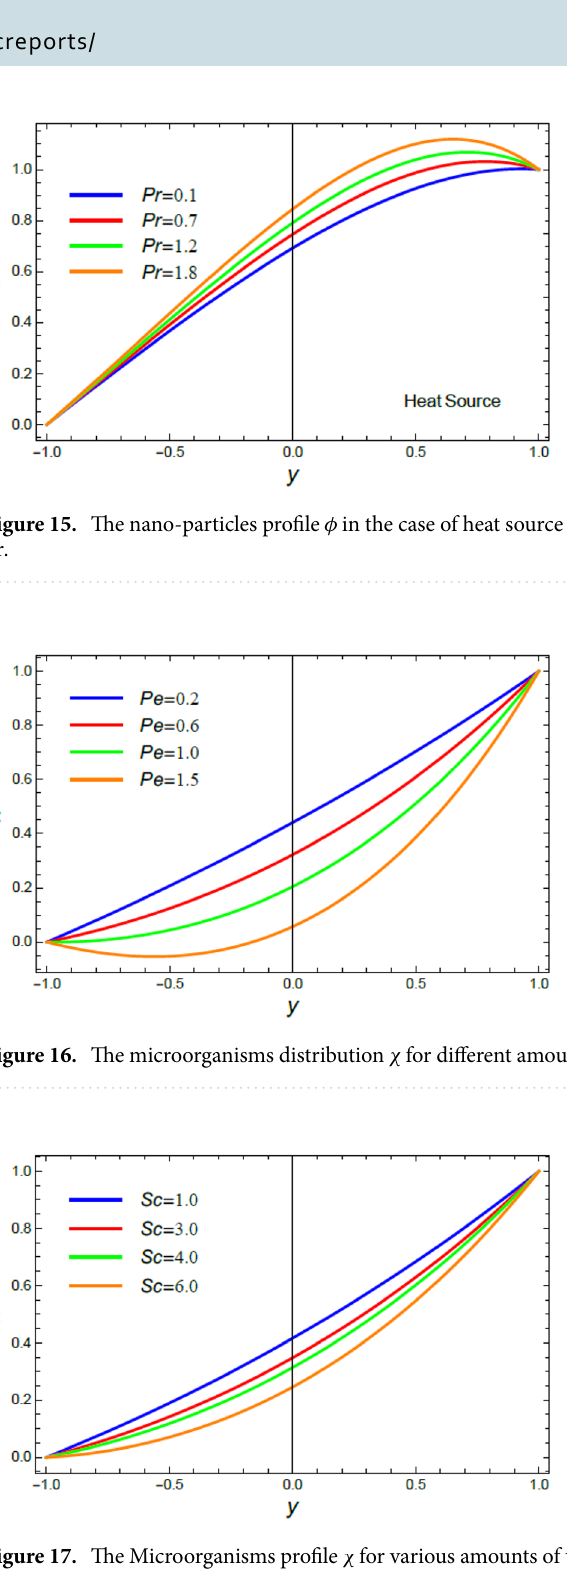
Figure 17. The Microorganisms profile χ for various amounts of the Schmidt numeral Sc